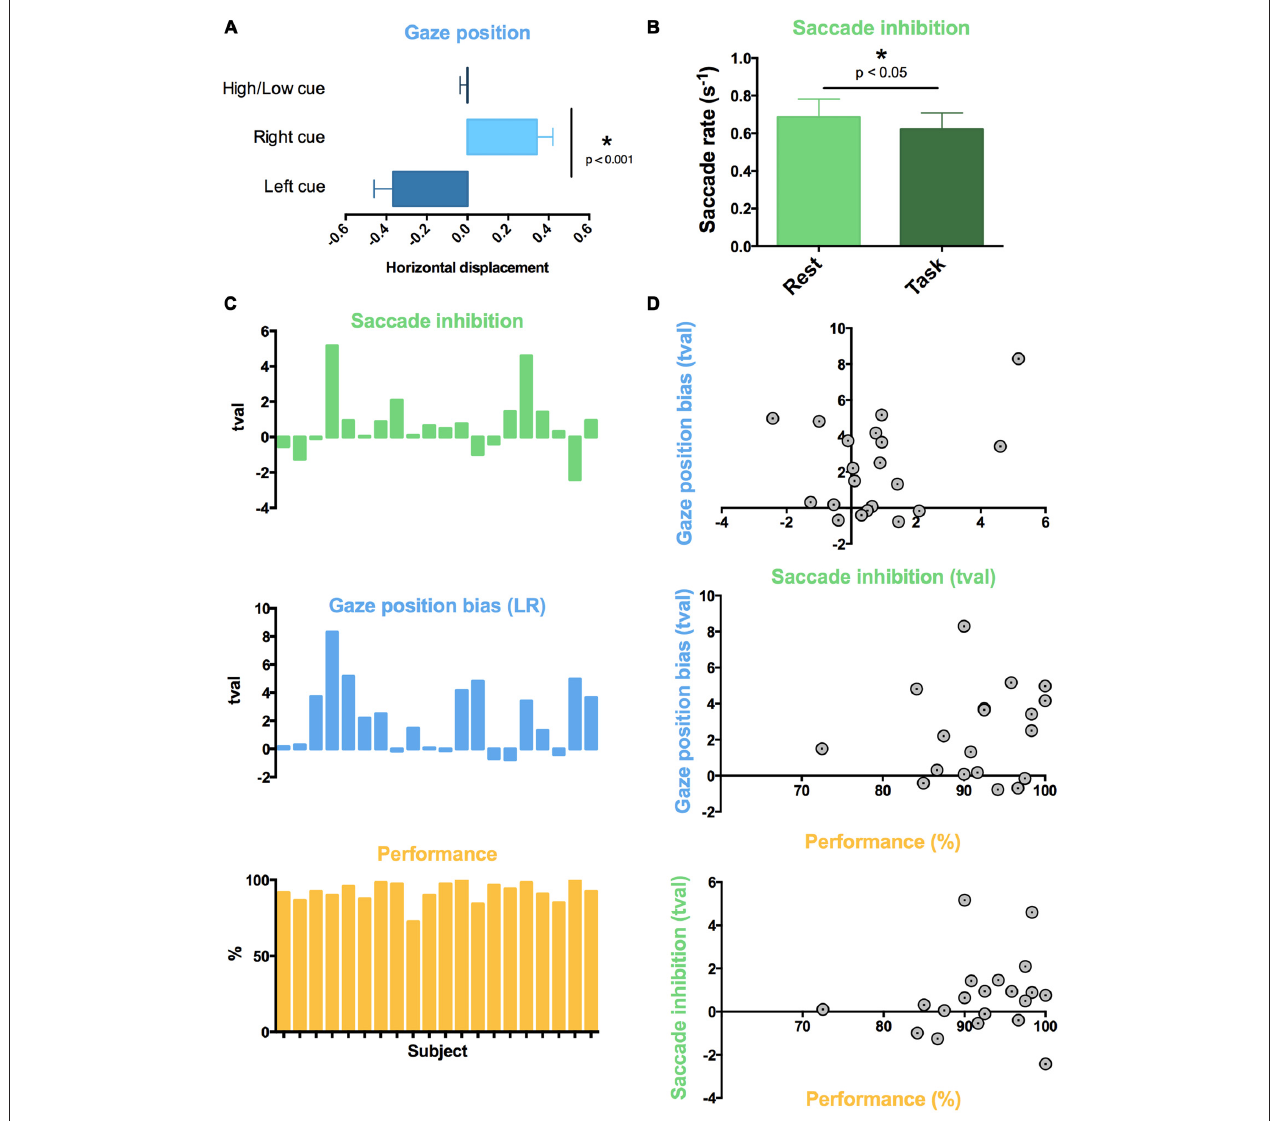
FIGURE 3 | Individual variability in auditory task-evoked eye movement control and performance. Across all 20 subjects, (A) attentive listening following spatial cues resulted in a gaze position bias towards cued sound, and (B) attentive listening reduced saccade rate compared to interleaved rest trials. (C) Graphs showing t -value (tval) for each subject for the comparison of saccade rate (green; Task vs. Rest) and mean gaze position difference (blue; Listen Left vs. Listen Right Trials), and percent correct responses for each subject (Performance). High inter-subject variability was found in saccade inhibition (all trials) and gaze position bias (spatially cued trials). (D) Individual differences in saccade reduction and gaze position bias did not correlate to individual differences in task performance or with each